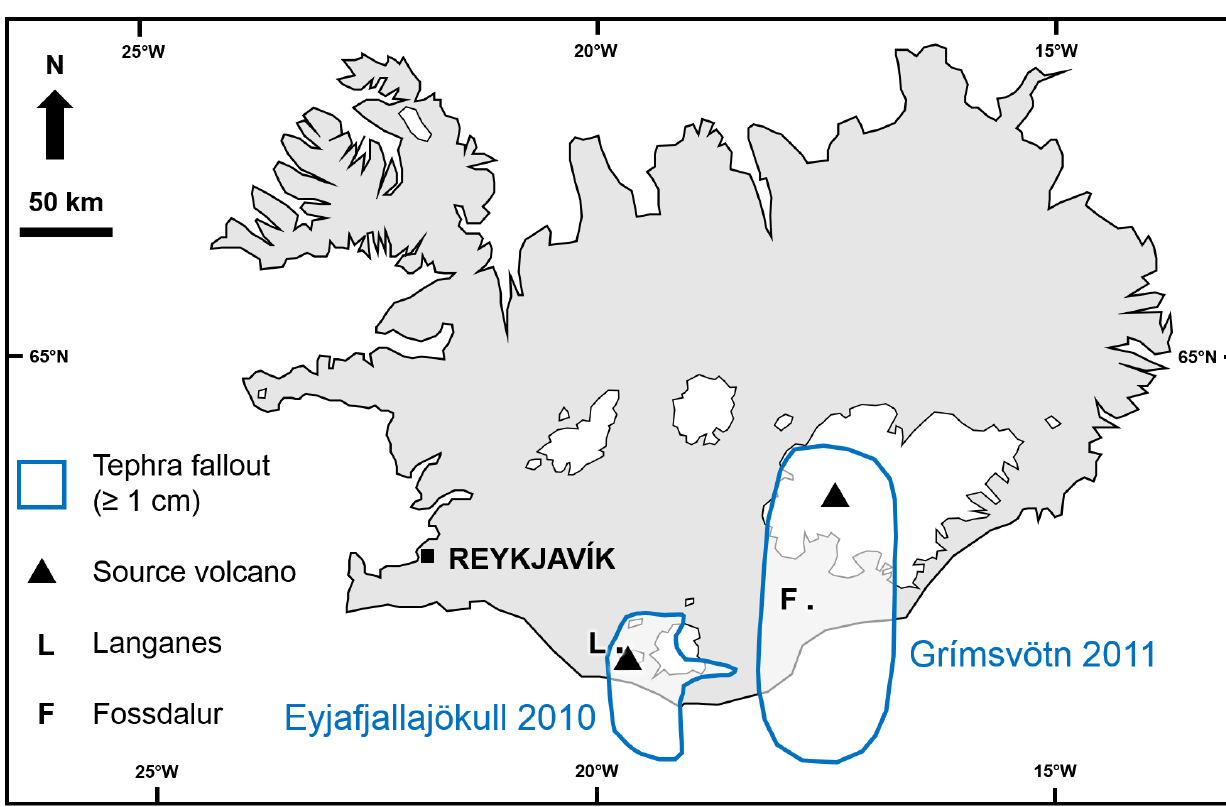
Figure 1: Map of Iceland showing the research locations (Langanes and Fossdalur) and the areas of tephra fallout (Eyjafjallajökull 2010 and Grímsvötn 2011) that exceeded 1 cm in